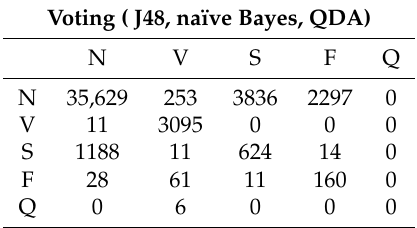
Table 10. Confusion matrix for combining J48, naïve Bayes, and QDA classifiers using a voting scheme.